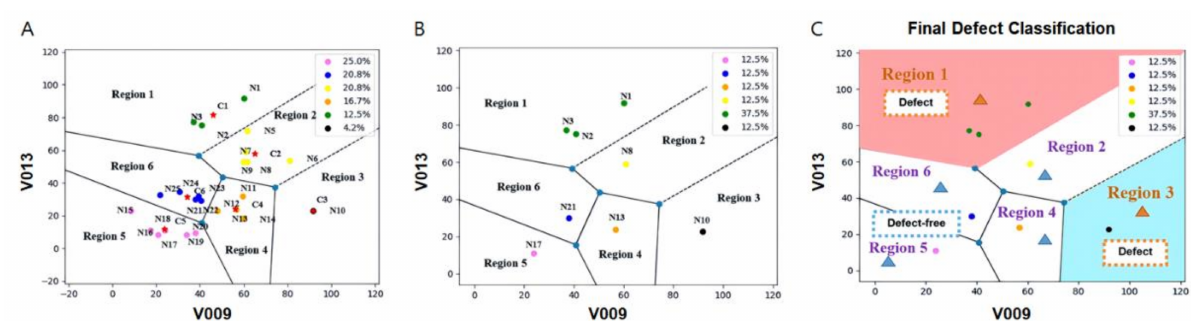
Figure 6. Fault detection and classification using the clustering method. ( A ) Imbalanced dataset marking the data ( N i ) and the centroid ( C i ). ( B ) Balanced dataset processed from the imbalanced dataset to match the amount of data in the minority group and the number of centroids in the majority group. ( C ) Final defect classification. When new data were generated, the algorithm determined whether the data had defects or were defect-free based on the region where the data were